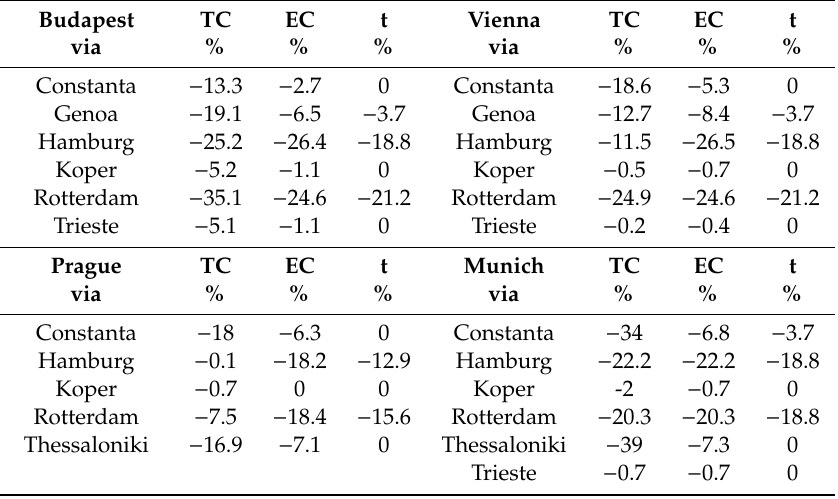
Table 4. Potential opportunities to improve e ffi ciency on transport routes from Shenzhen to central European destinations, according to